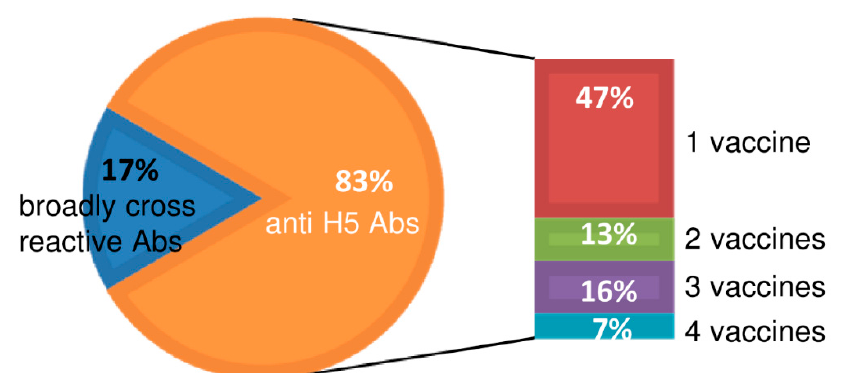
Figure 7. A pie chart indicating the ratio of anti-H5 antibodies that bound only to H5N1 strains compared to broadly cross-reactive antibodies that bound to H5N1, H1N1, H3N2, and type-B strains. Each of the percentages indicates distribution of representative clones categorized based on their cross-reactivity among H5N1 and H1N1 strains. The bar graph shows the percentage of anti-H5 antibodies categorized into 4 groups based on their cross-reactivity among the four H5N1 vaccine strains used in the present study.